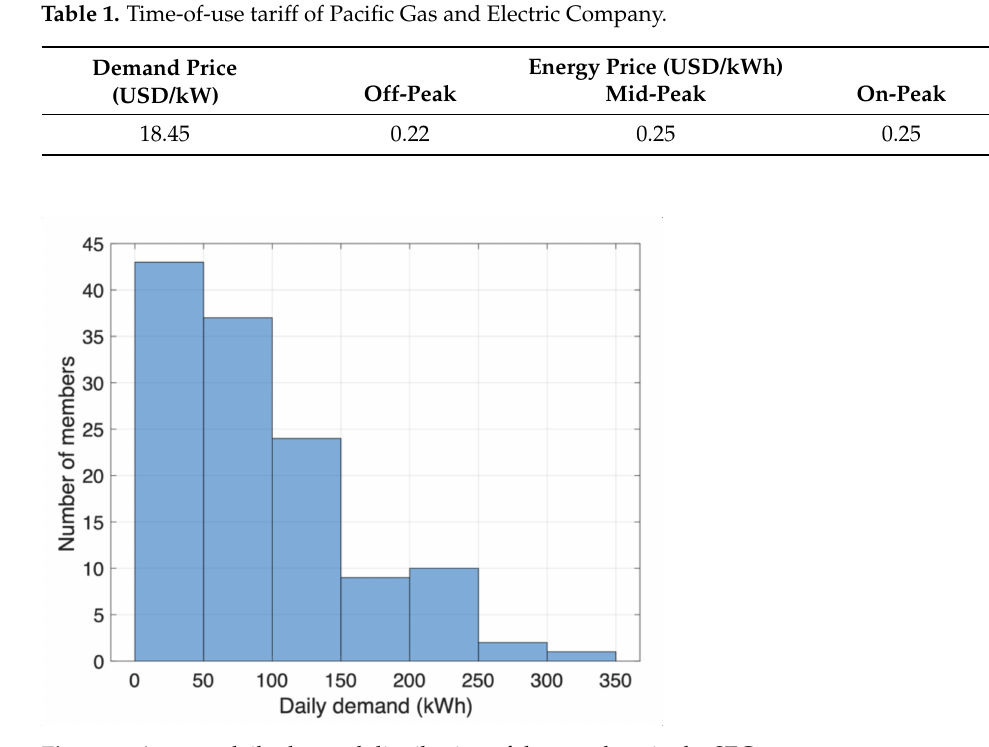
Figure 5. Average daily demand distribution of the members in the SEC.